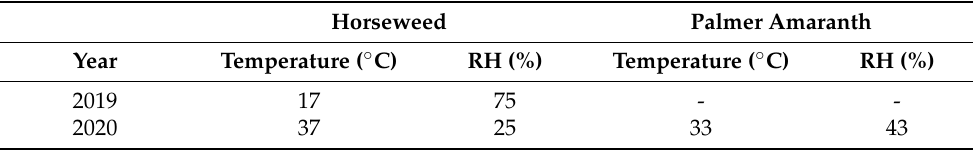
Table 2. Temperature and relative humidity (RH) during applications in the field sites of horseweed and Palmer amaranth in 2019 and 2020 growing seasons. Horseweed Palmer Amaranth Year Temperature ( ◦ C) RH (%) Temperature ( ◦